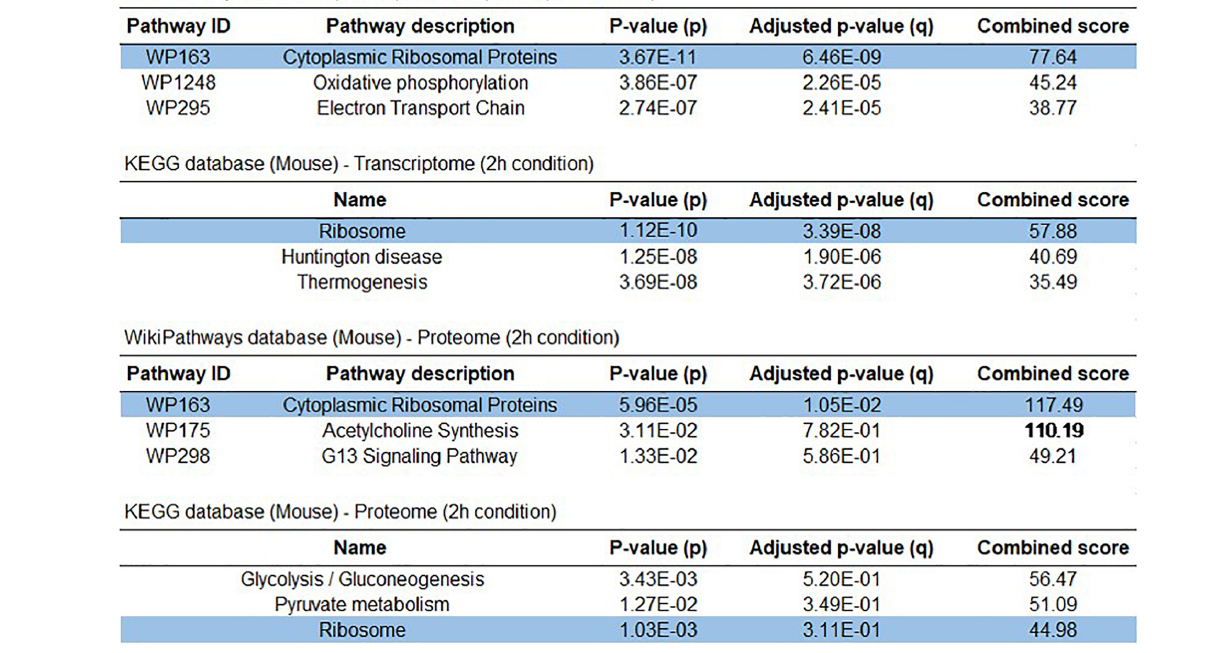
FIGURE 4 | Early Sox9 expression is involved in ribosomal pathways. Top 3 identified enriched pathways from WikiPathway 2019 and KEGG2019 pathway analysis in control RNAi compared to Sox9 RNAi at 2-h condition in ATDC5 differentiation for transcriptome and proteome data sets.